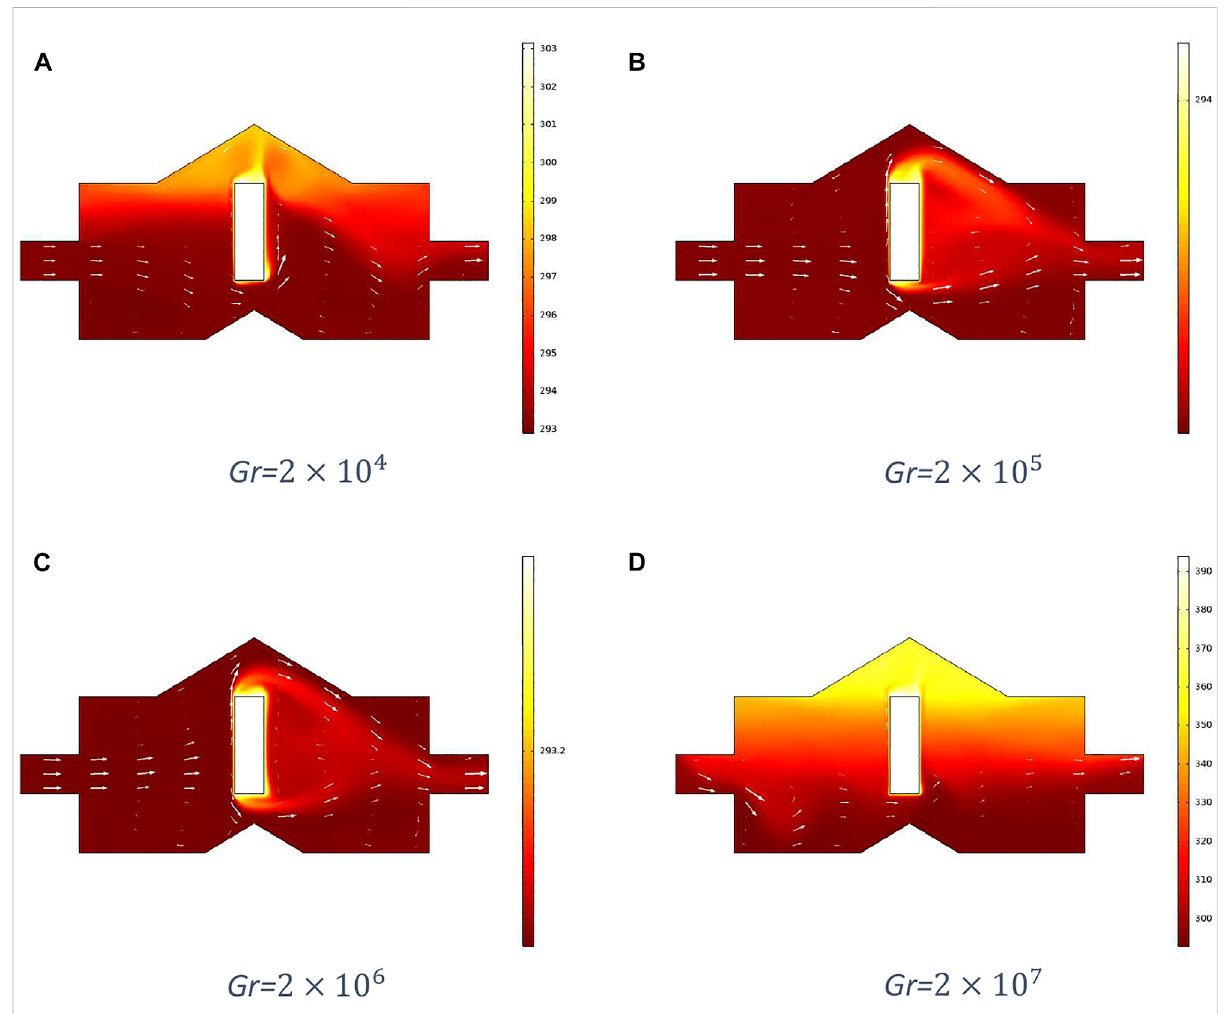
FIGURE 8 Temperature distribution at Re = 1,000 and at different Grashof Number.